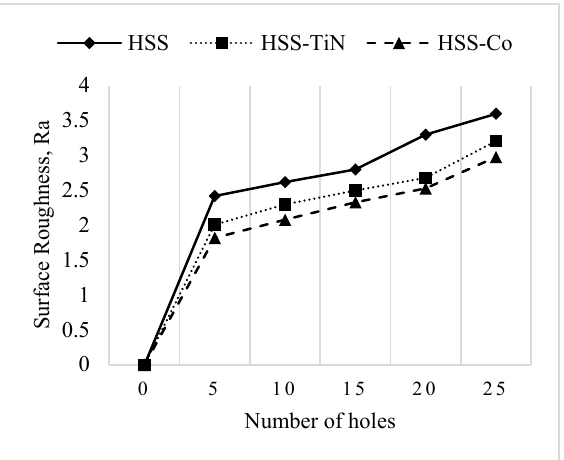
Figure 8. Surface roughness value of different cutting tools at a spindle speed of 250 rpm.